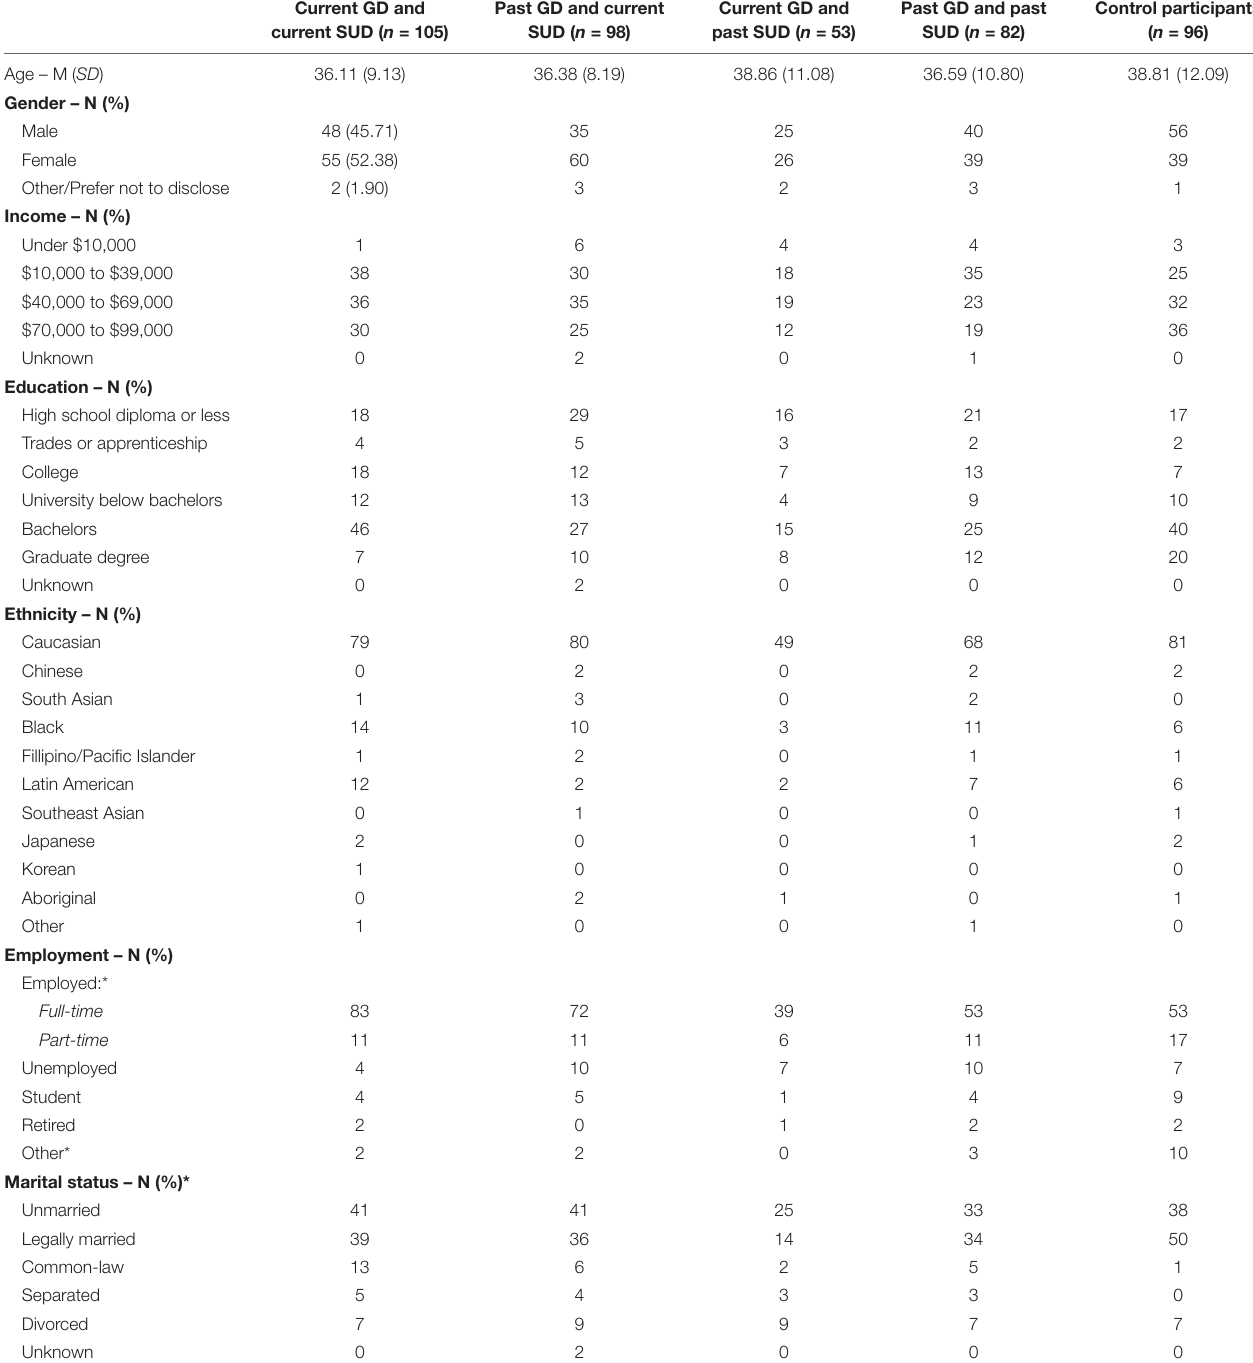
TABLE 1 | Demographic information for participants across